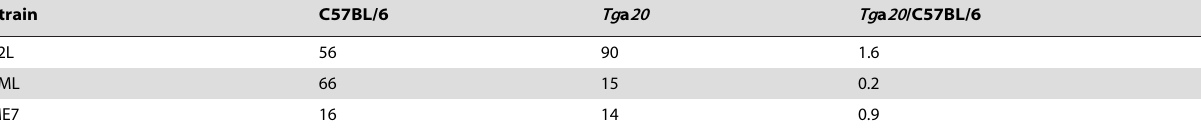
Survival times + Titer Averageindays 6 SD(n)